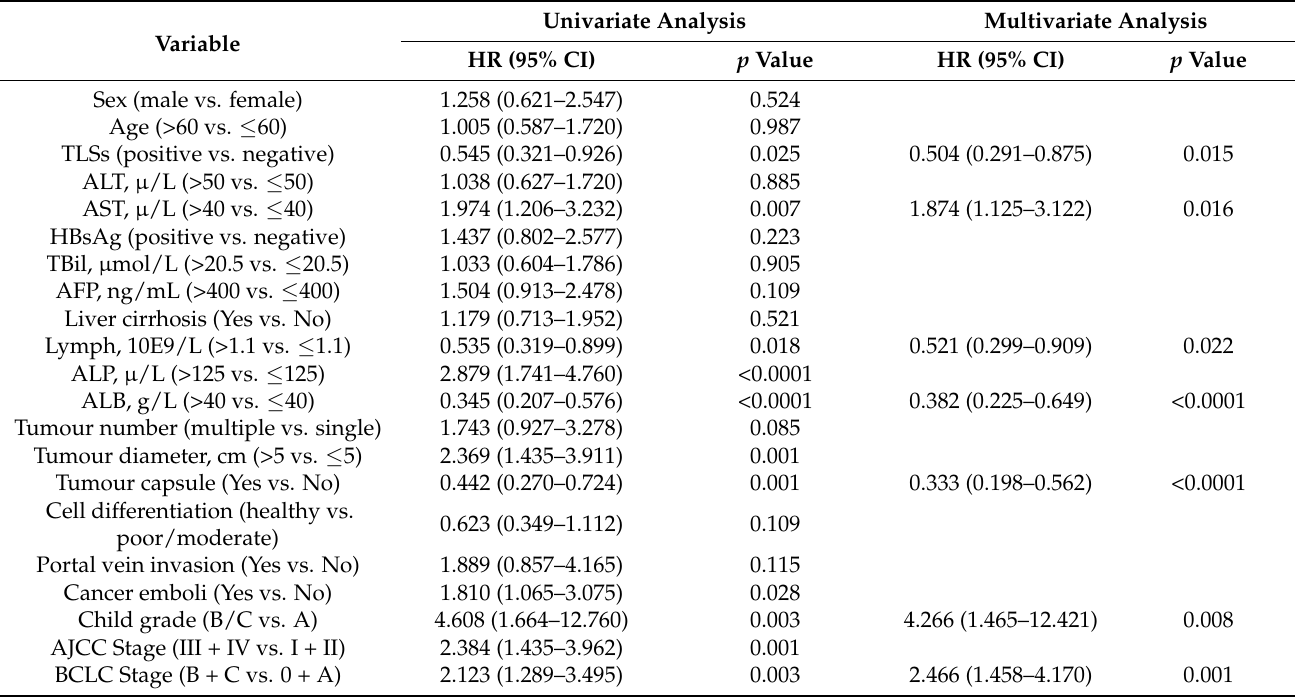
Table 2. Univariate and multivariate Cox regression analyses of risk factors associated with recurrence-free survival from the Xijing Hospital data (HCC patients did not receive any other anti-tumour therapy prior to tumour